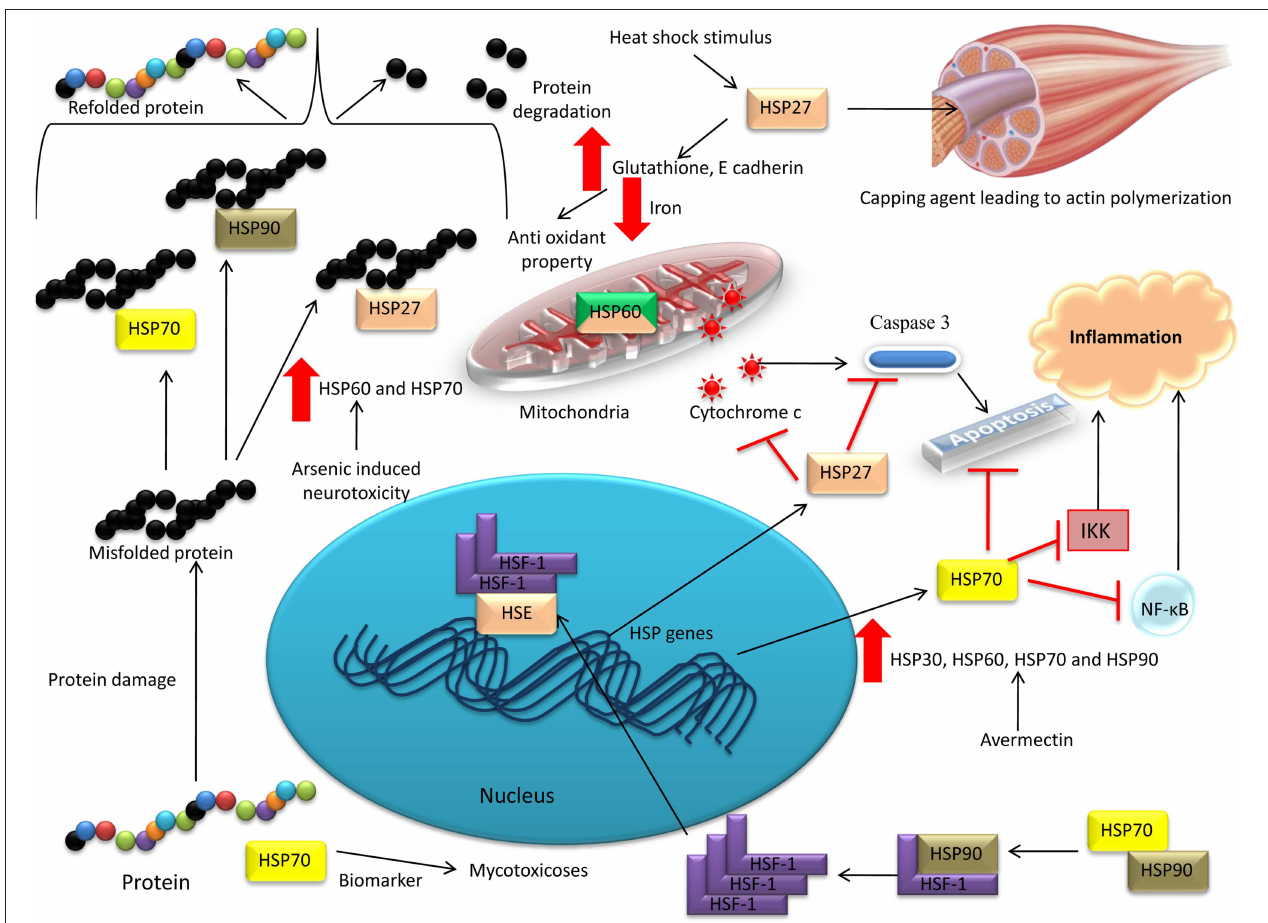
FIGURE 2 | Heat shock proteins as stress biomarkers. HSP70 has been reported as a biomarker in monitoring environmental diseases, such as mycotoxicoses. HSP27 was characterized as a potent marker for thermal stress, facilitating the effective re-orientation of misfolded proteins. HSP27 inhibits the intrinsic and mitochondrial apoptotic pathways via its action on Bax and cytochrome c. HSP60 and HSP70 was demonstrated to have neuroprotective function in arsenic-induced neurotoxicity in red jungle fowl. HSP30, HSP60, HSP70, and HSP90 were elevated in an Avermectin toxicity model in the cardiac tissues of